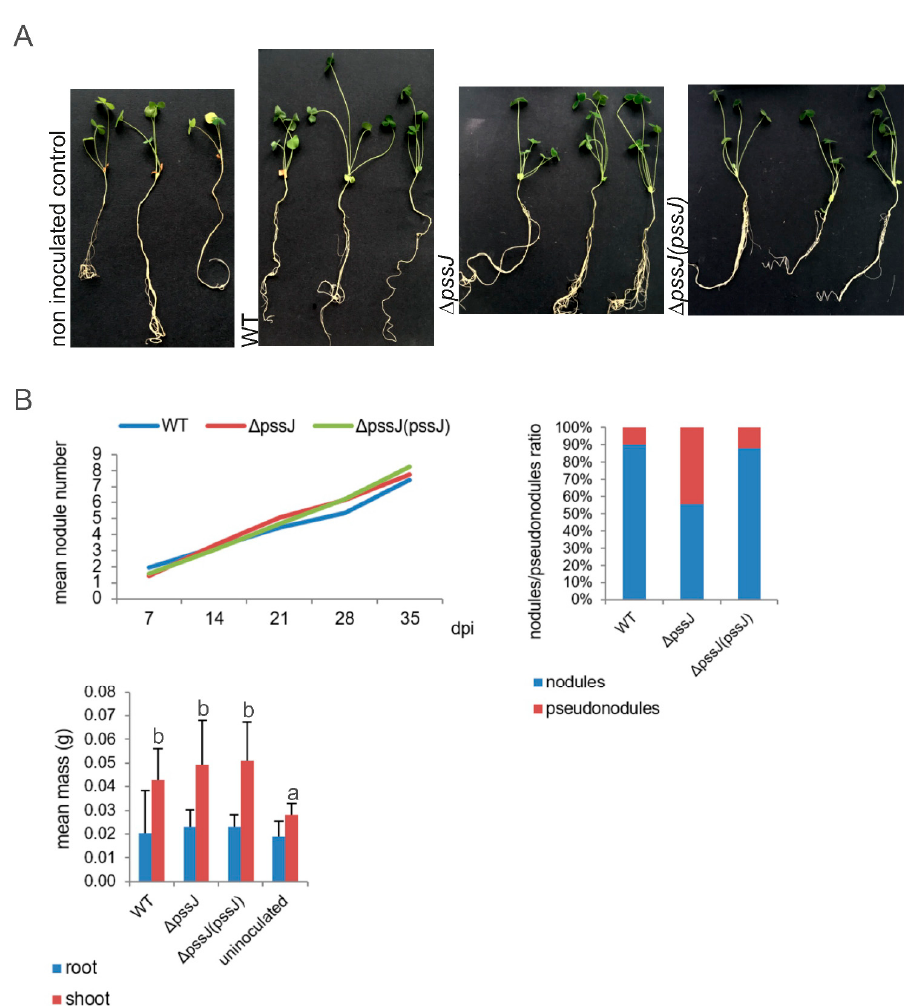
Figure 6. Symbiotic performance ( A ) and nodulation phenotypes ( B ) of wild type RtTA1 and its derivatives Δ pssJ and Δ pssJ ( pssJ ) on clover. Symbiotic performance was measured as nodulation kinetics throughout the experiment, number of nodules, and masses of shoots and roots. Significant differences in the shoot mass of clover infected with the wild type RtTA1 and its derivatives at p < 0.05 are marked with different letters above the standard deviation bars.